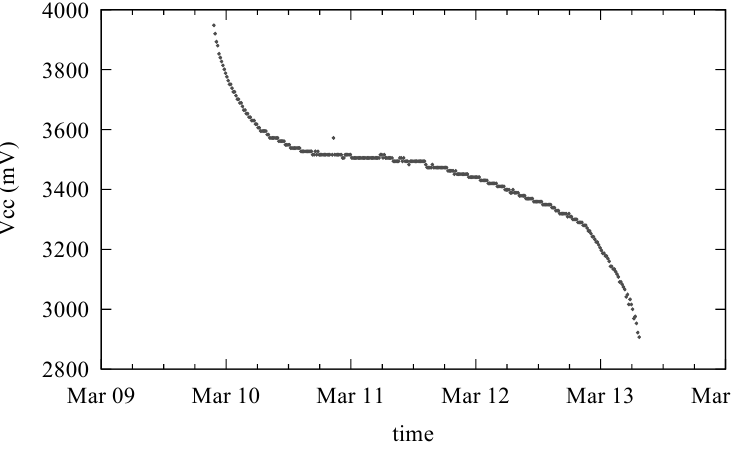
Figure 10. Variation of the power supply (Vcc) during the